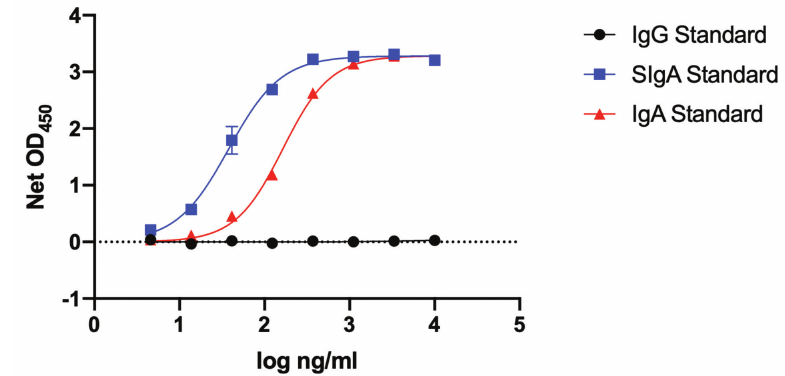
Figure 3. Specificity and sensitivity of IgA detection. Purified human IgG, purified SigA, and recombinant, dimeric IgA lambda were coated onto ELISA plates and detected with the same goat anti-human IgA- 1 HRP conjugate used in the assays to detect saliva and serum IgA S-protein antibodies. The plot shows net OD450 values (+/- SEM) as a function of the logarithmic concentrations of the 3 antibodies added to the ELISA wells during the coating